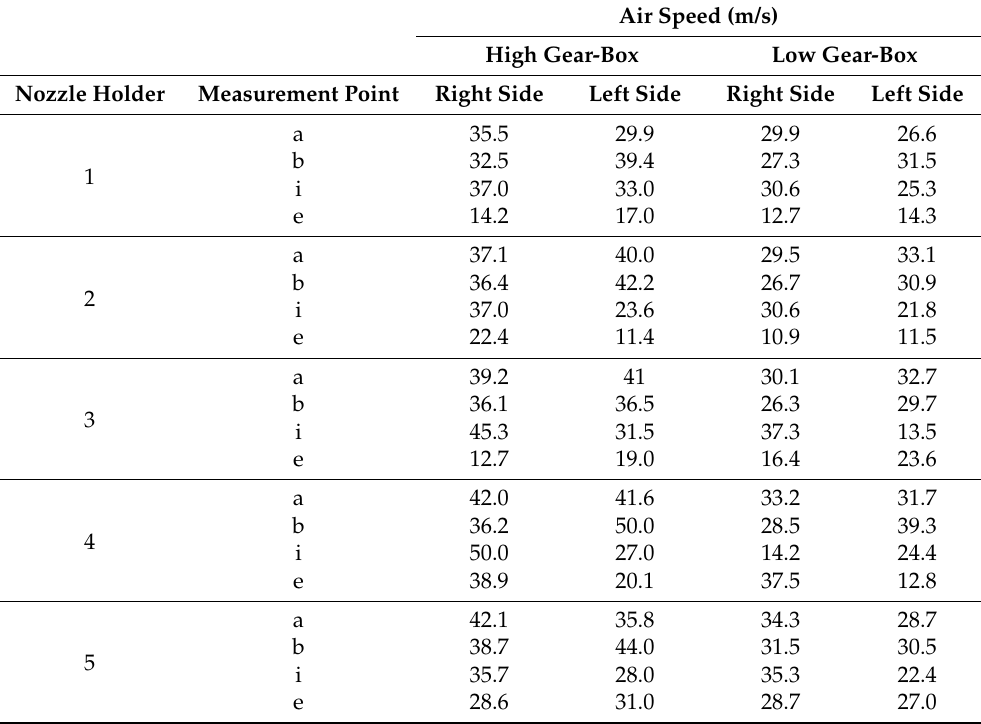
Table A26. Average air speed (m/s) in the measurement points of the T